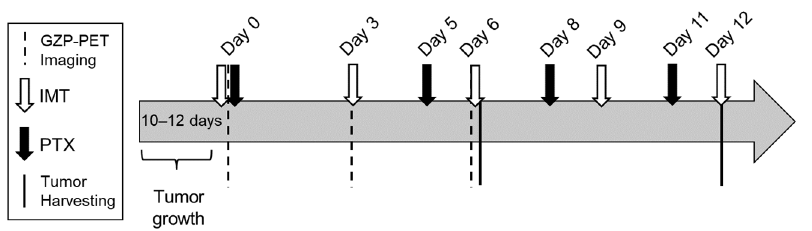
Figure 1. Experimental timeline showing tumor implantation, imaging, and treatment schedule. Thresholds for response to treatment were determined as one standard